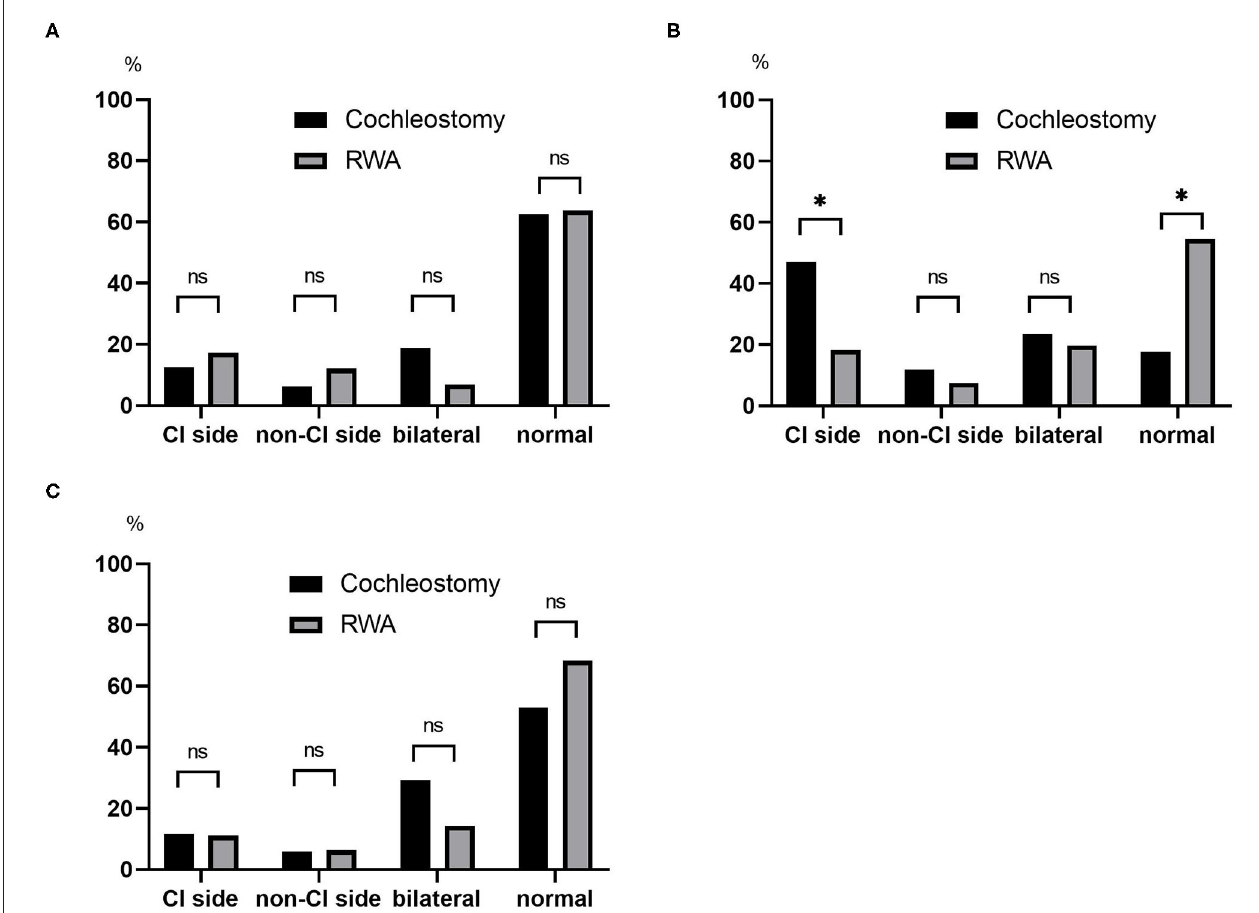
FIGURE 2 | The frequencies of post-operative abnormal results on the CI side, non-CI side, bilaterally absent and post-operative normal reactions based on (A) caloric testing, (B) cVEMP, (C) oVEMP were compared between the RWA and cochleostomy. The frequency of abnormal post-operative cVEMP responses on the CI side in cochleostomy patients was significantly higher than that in RWA patients ( p = 0.023). ns, not significant; *p <